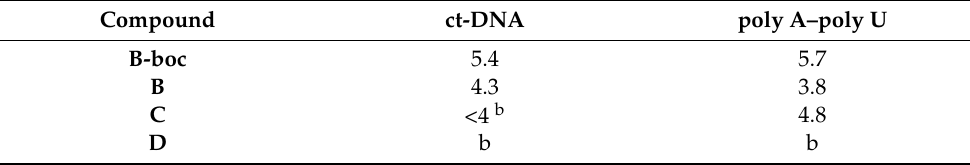
Figure 6. Fluorimetric titration of B , B-boc , C ( c = 1 × 10 − 6 M; λ exc = 353 nm) with ct-DNA and poly A–poly U: dependence of fluorescence at λ max = 475 nm on c (DNA, RNA). Done at pH 7, sodium cacodylate buffer, c = 50 mM. Table 3. Binding constants (log K s ) a and spectroscopic properties of complexes of conjugates B , B-boc, C , D with ds-polynucleotides calculated by processing fluorimetric titrations, done at pH = 7, sodium cacodylate buffer, c = 50